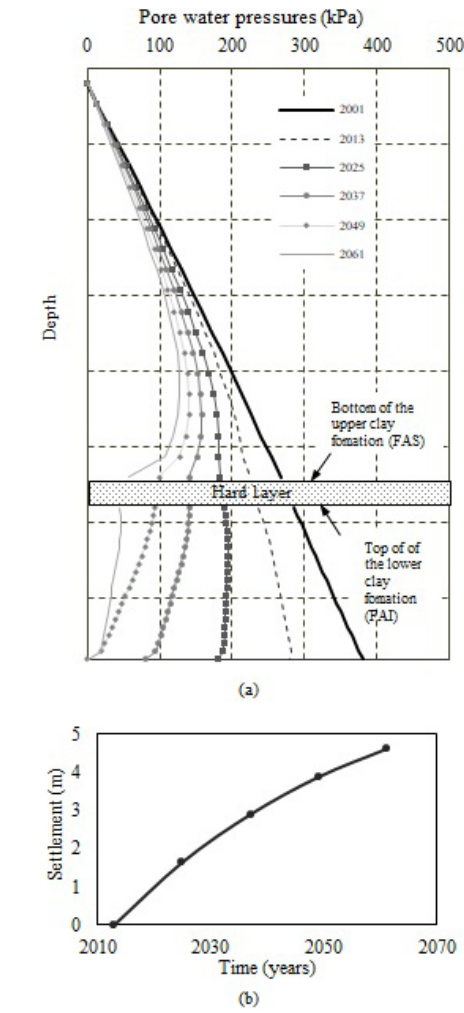
Figure 5. (a) Pore pressure evolution and (b) accumulated settle- ment, site